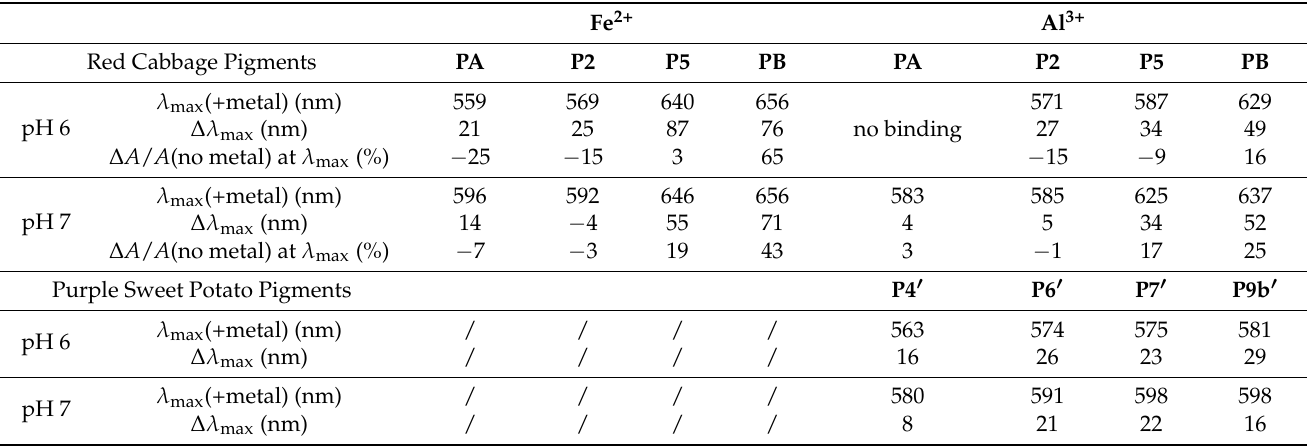
Purple Sweet Potato Pigments